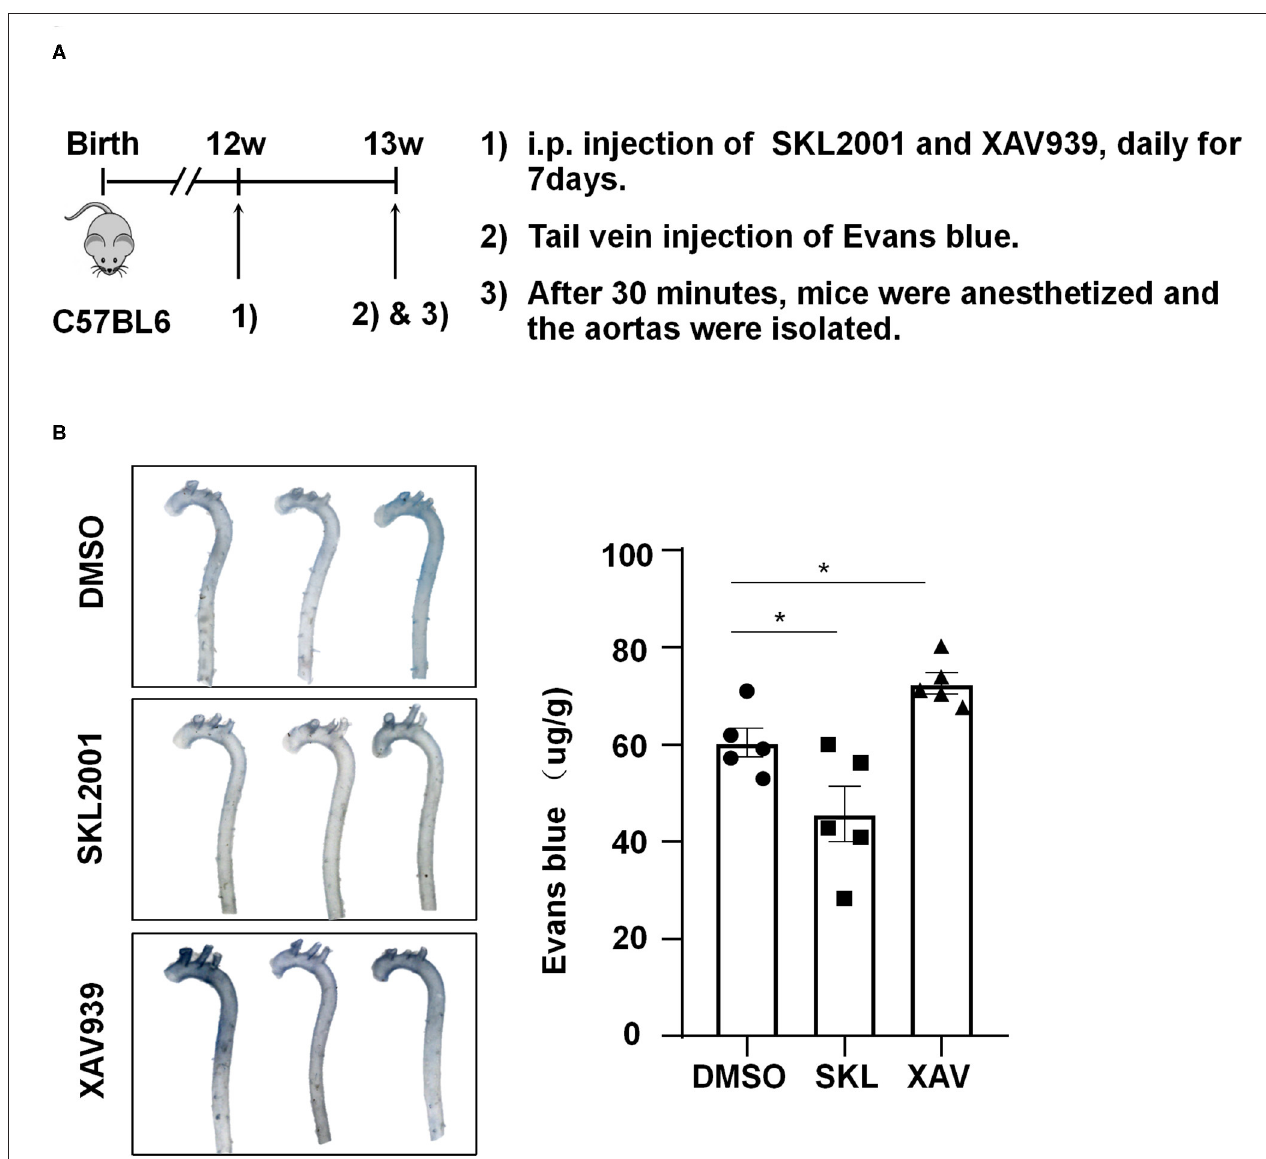
FIGURE 7 | The activity of β -catenin is important for maintaining the arterial endothelial barrier function in vivo . (A) Timeline diagram of the animal experiment. (B) Mice were injected intraperitoneally with SKL2001 (6 mg/kg in 100 ul of DMSO), XAV939 (4 mg/kg in 100 ul of DMSO) or DMSO (100 ul) daily for 7 days. The arterial endothelial permeability to Evans blue dye was assessed. Each symbol represents one animal. One-way ANOVA, * P < 0.05 compared with the indicated